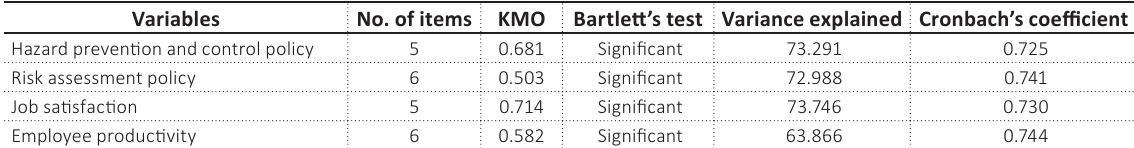
Table 4. Summary of exploratory factor analysis and reliability test results